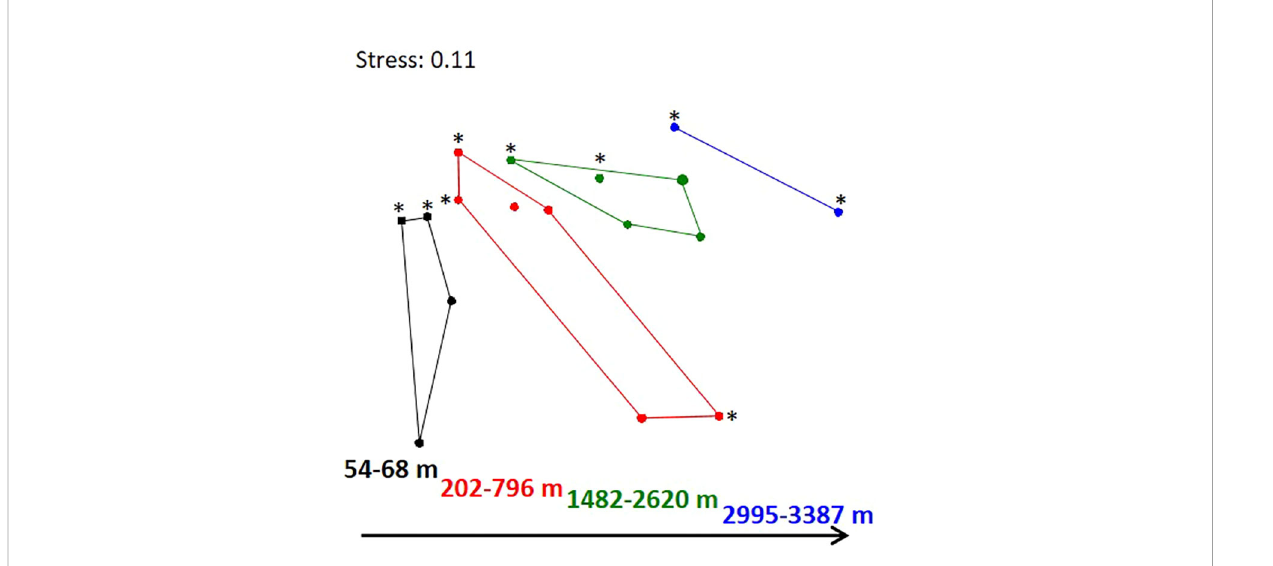
FIGURE 6 Differences in bacterial community structure with water depth and between 1993 and 2012. Non-metric multidimensional scaling plot based on Bray-Curtis dissimilarities of 454 tag sequencing data. Samples from 2012 are marked with an asterisk